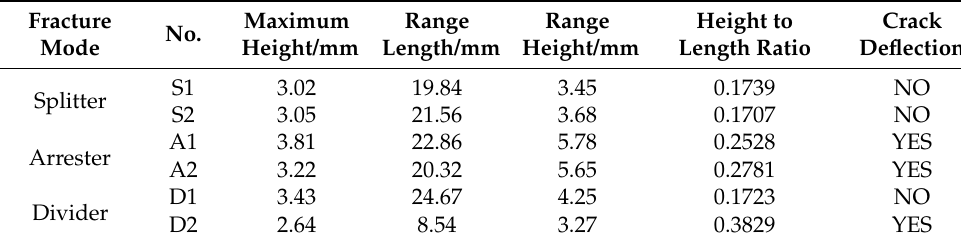
Table 6. The geometric size index of the process zone for three modes of specimens. Fracture Mode